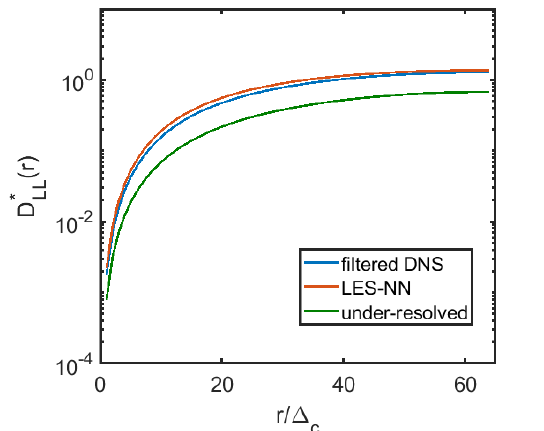
Figure 7. The second-order nondimentional longitudinal structure function D ∗